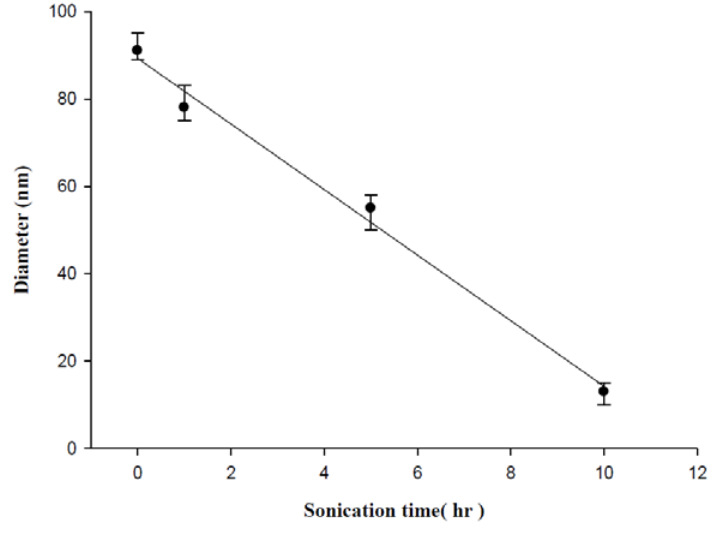
Figure 6. Mean diameter of DNA-mediated gold nanoparticles as a function of the sonication